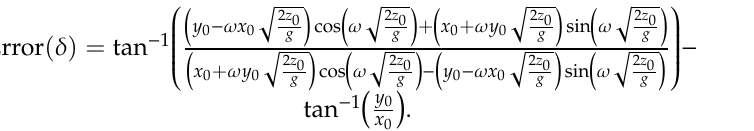
Table 2. The obtained errors of the Cartesian coordinates of the falling point G ( x G , y G ,0 ) in the frame ( x , y , z ) and the corresponding errors in the polar coordinates ( ρ , δ ) at several points Q ( x λ = 0, π .